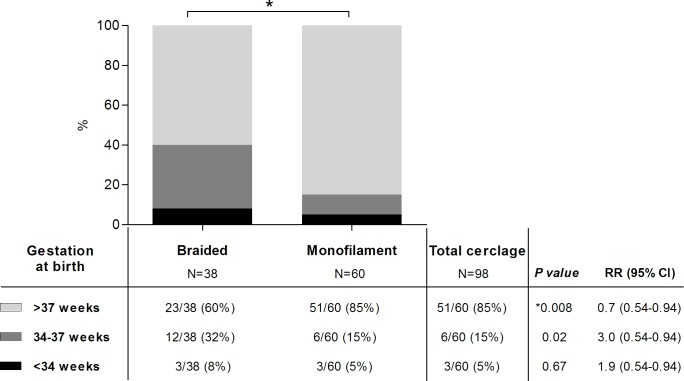
Gestation at delivery in women with an ultrasound-indicated cerclage for CL <25mm before 24weeks: a comparison of suture material braided versus monofilament.Preterm birth <37weeks was significantly higher (P = 0.08) in women with braided cerclages, compared to monofilament cerclages. This is difference is most notable among those delivering late preterm birth (34-37weeks).